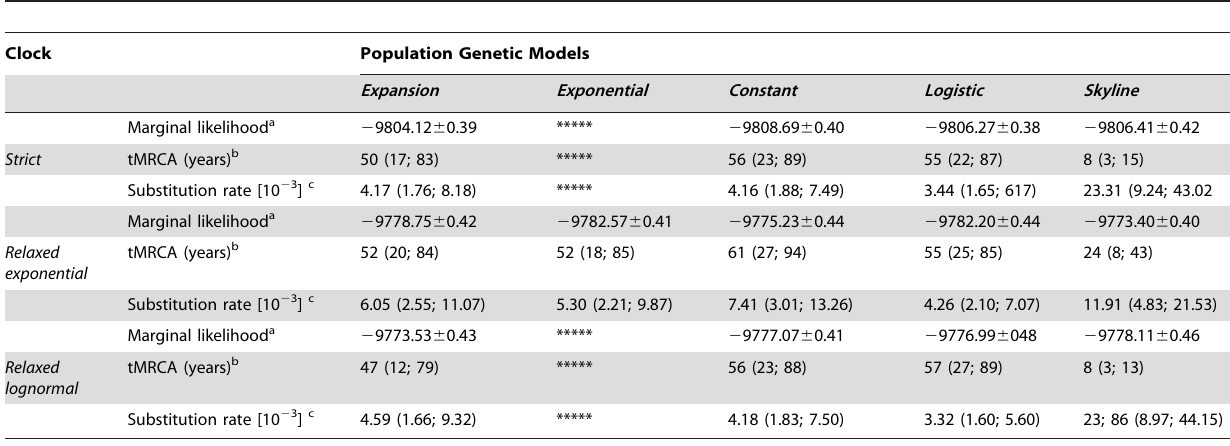
Table 3. Estimates of the substitution rate and the tMRCA of HCV for the E2 gene with HVR1 by Bayesian coalescent methods, under several molecular clock and population genetic models.